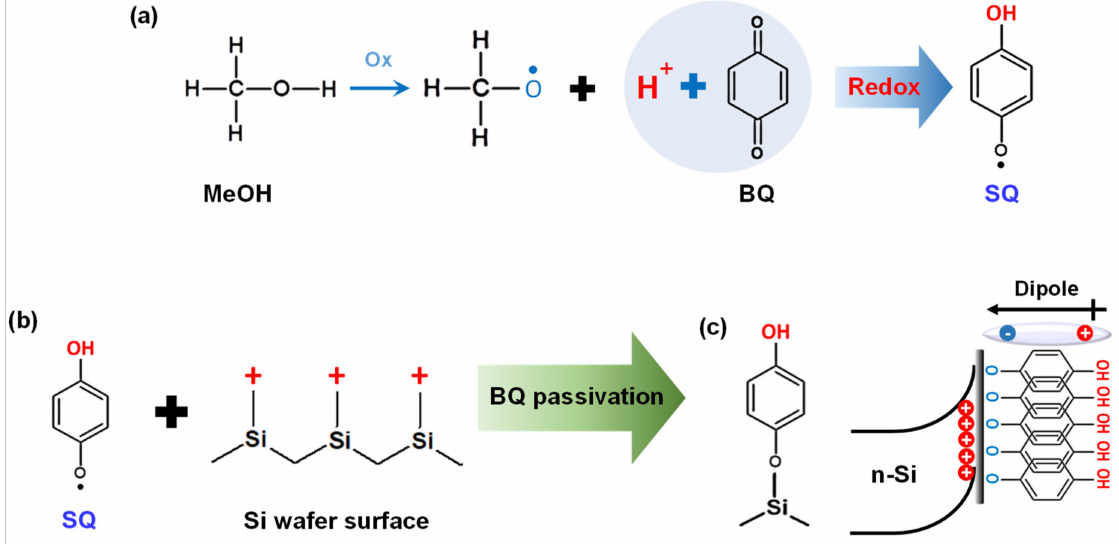
Figure 8. ( a ) Reduction reaction of BQ to form SQ, ( b ) schematic illustration of SQ passivation on Si surface, and ( c ) energy alignment of SQ molecules on n -Si